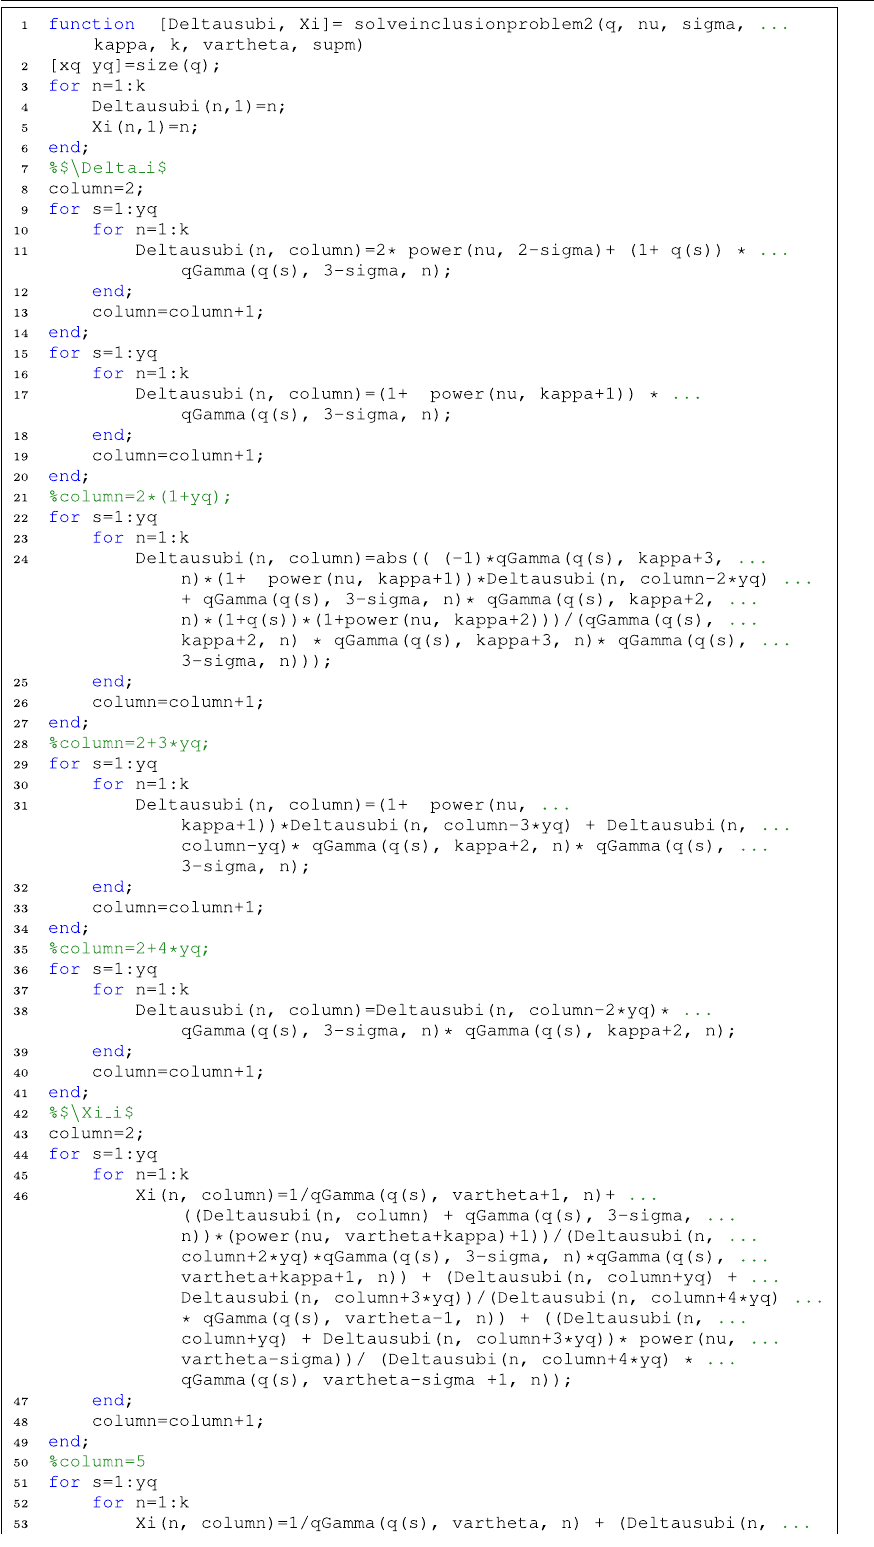
Algorithm 7 The proposed method for calculated (cid:20) i and Ξ i in Example